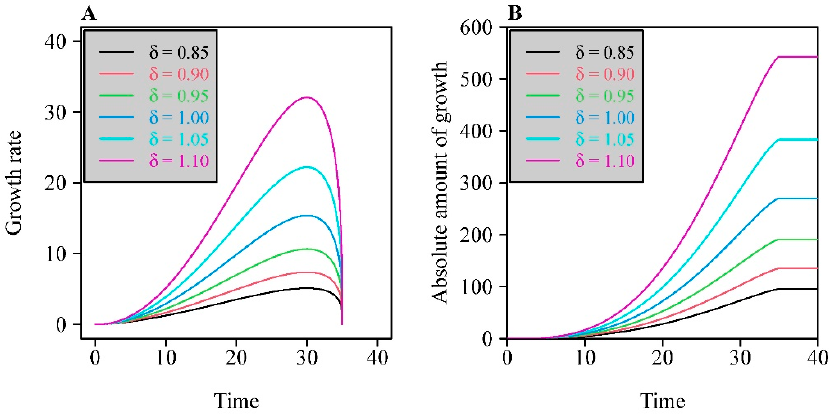
Figure 1. Influence of the new additional parameter, δ , on the shape of the curves plotting the modified Brière equation ( A ), and on those plotting the sigmoid equation based on the integrated form of the modified Brière equation ( B ). Here, a = 0.01, m = 3, x min = 0, and x max = 35. In this example, no specific units are used; the x ‐ axis represents a generic time variable (hours, days, weeks, etc.) and the y ‐ axes generic ( A ) growth rate (cm day − 1 , g h − 1 , etc.) and growth (cm, g, etc.) metrics.